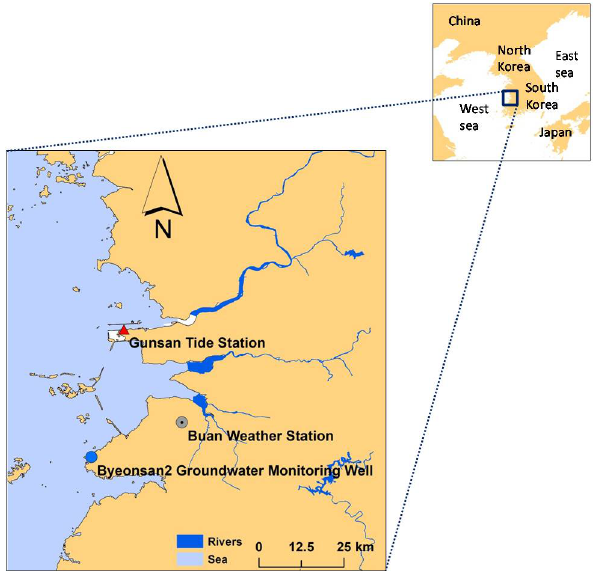
Figure 1. Location map of the Gunsan tide gauge station (35.98° N 126.56° E), the Byeonsan2 groundwater monitoring well for seawater intrusion (35.64° N 126.48° E), and the Buan weather station (35.73° N 126.72° E).